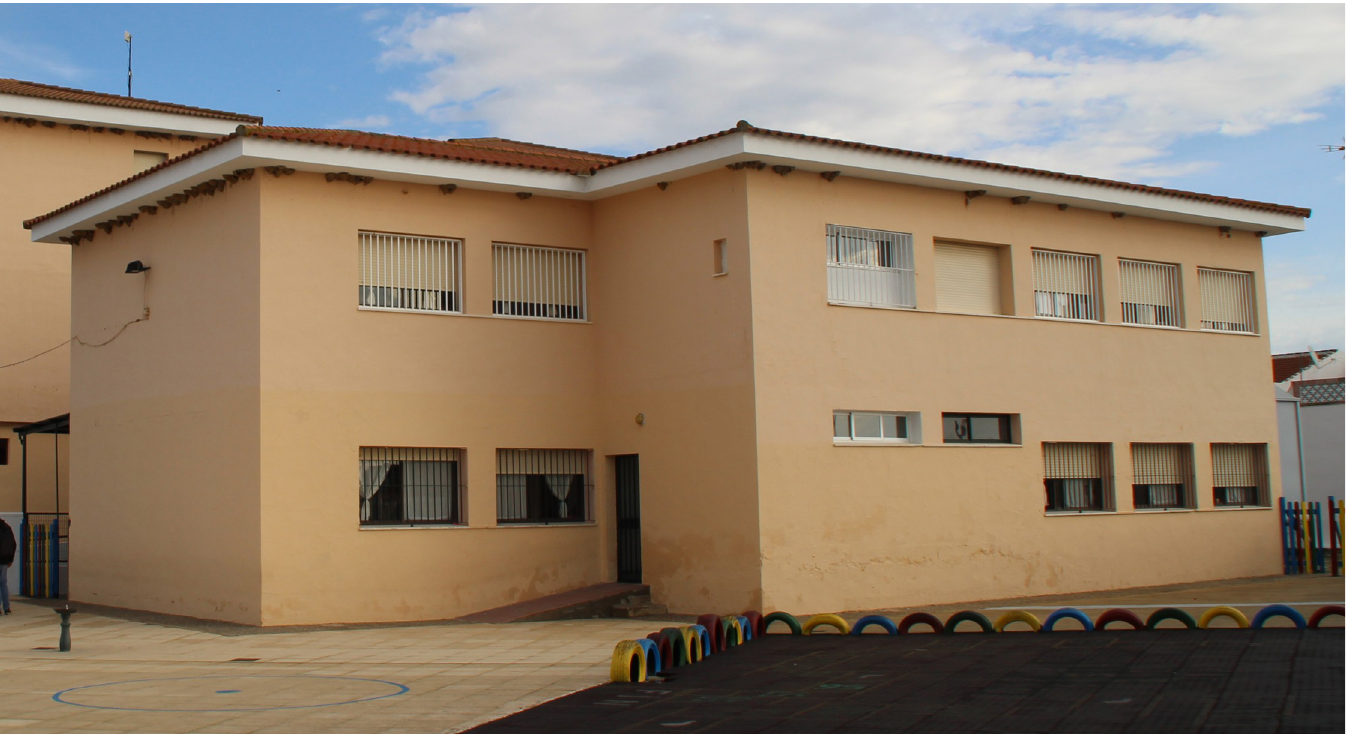
Fig 1. Fac¸ade of the building selected as case study (Authors’ ownership).